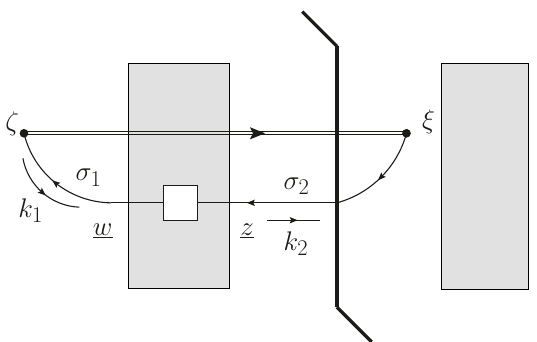
Figure 1. Diagram of class B with kinematics specified. The antiquark propagates from ζ to w with momentum k 1 , undergoes a sub-eikonal interaction with the proton which changes its transverse position from w on the left of the shock wave (the left shaded rectangle) to z on the right of the shock wave, and then propagates from z to ξ with momentum k 2 . The sub-eikonal interaction with the proton shock wave (shaded rectangle) is denoted by the white